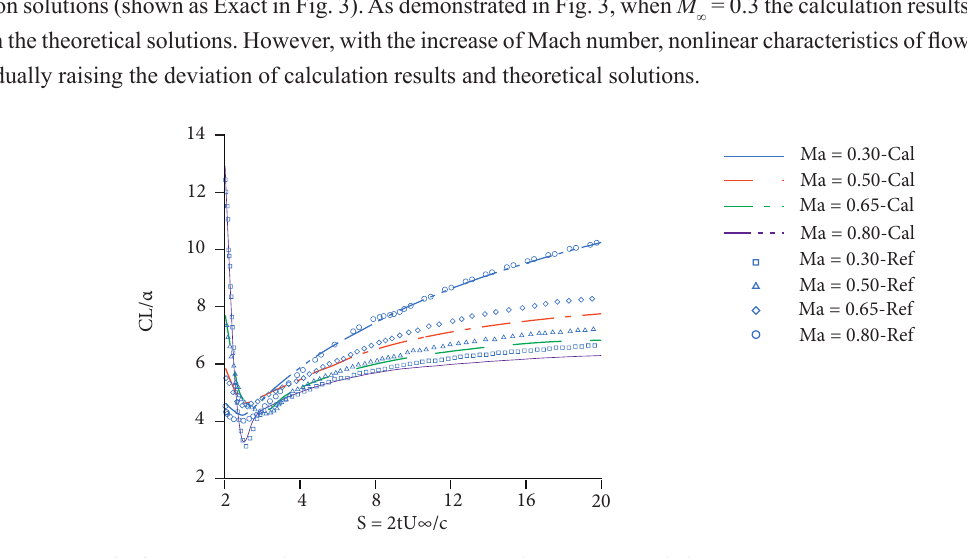
Figure 2. Comparisons of calculation value with reference value of lift